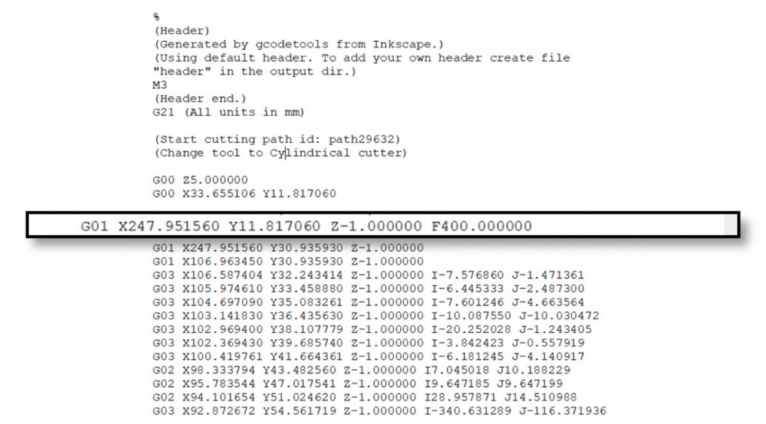
Figure 14. Example of a G-code